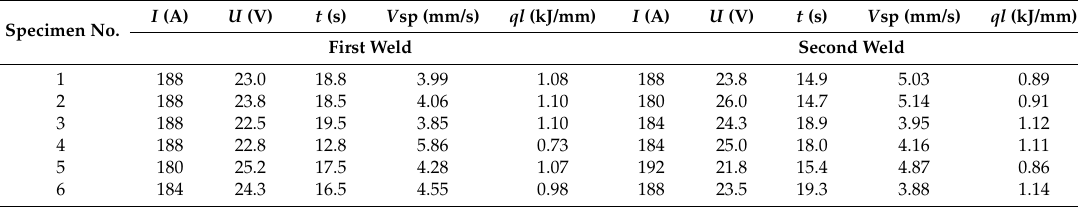
Table 3. Welding parameters for the controlled thermal severity (CTS) tests.